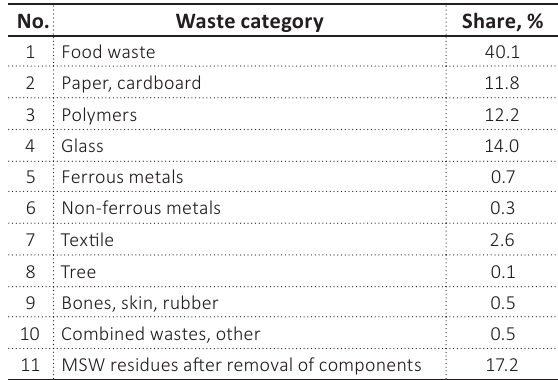
Table 2. Weighted average morphological composition of SHW in containers of residential buildings in Sumy, 2019